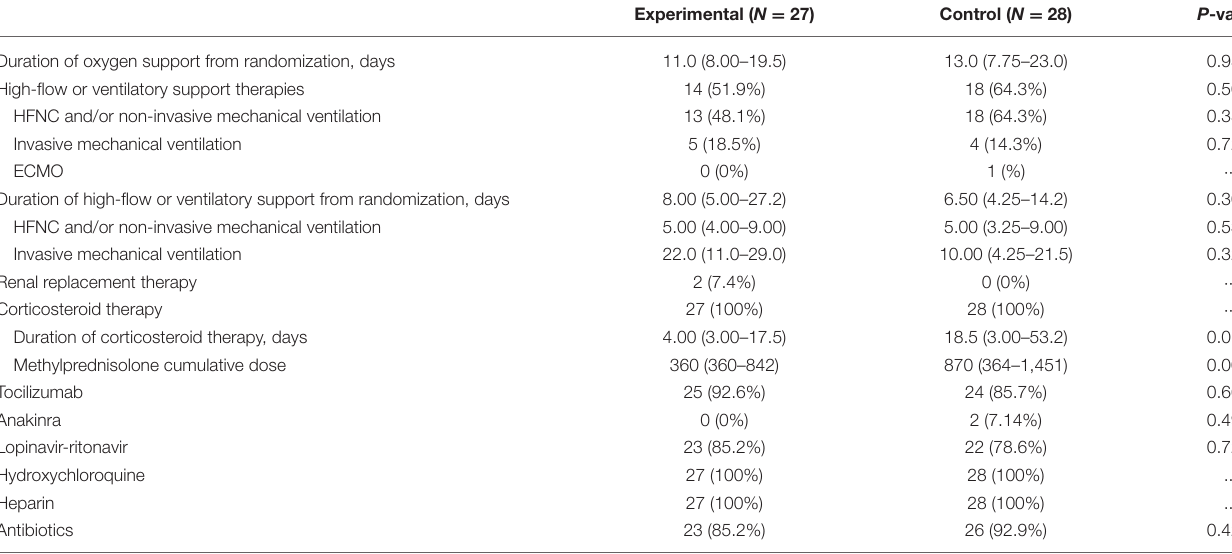
TABLE 2 | Treatments received during hospitalization and the trial period.